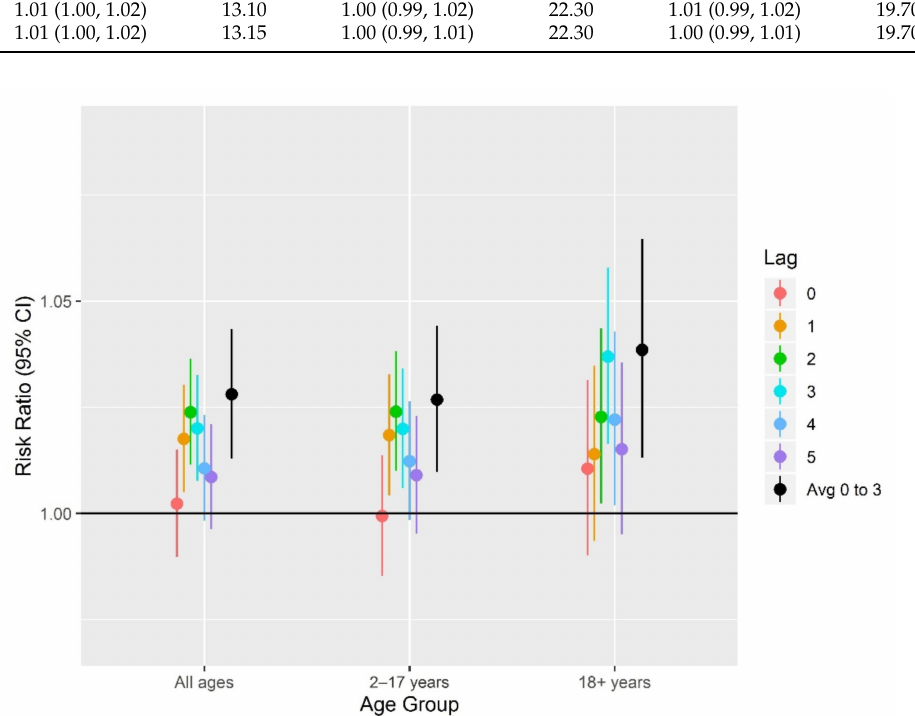
Figure 1. Risk ratios of respiratory ED visits in Mexico City corresponding to an interquartile increase in PM 2.5 concentration, by lag structure and age group. PM 2.5 was consistently associated with significant increases in population-level respiratory morbidity among both children and adults over multiple lag